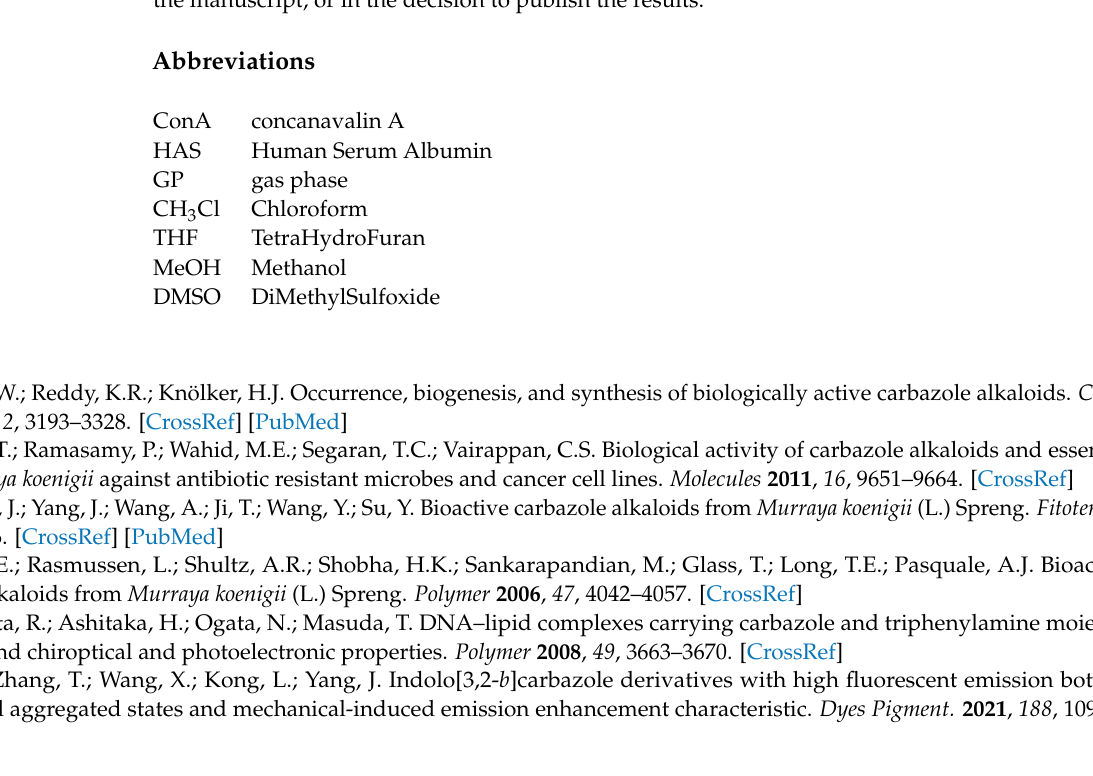
in eV, Table S2: CT parameters for the bright low-lying excited state, Table S3: Free energies ( ∆ G solv , kcal/mol) of solvation, Table S4: The theoretical vertical and cLR corrected excitation energies in nm. Table S5: Calculated values of dipole moments (in D) for the ground and CT excited state. Table S6: The theoretical de-excitation energies in nm determined using PBE0 functional. Table S7: Nonlinear optical properties. All values are given in (a.u.). Table S8: Two-photon absorption cross section. Table S9: Binding free energies ( ∆ G b , kcal/mol) obtained during AutoDock simulations with Conconavalin A. Table S10: Binding free energies ( ∆ G b , kcal/mol) obtained during AutoDock simulations with Human Serum Albuminum. Table S11: The calculated biological